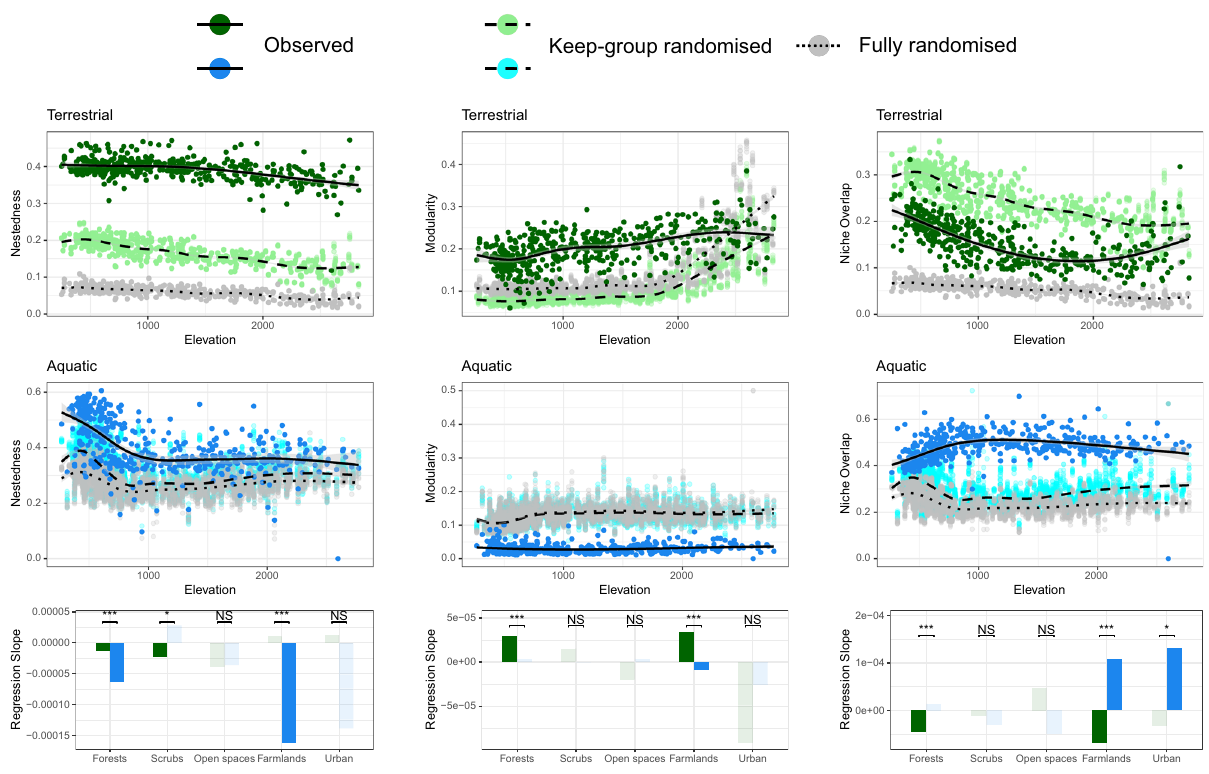
Fig. 5 | Nestedness (left panel), modularity (middle panel), and consumers ’ niche overlap (right panel) of terrestrial (green) and aquatic (blue) food webs alongelevation. Inthescatterplots,besidestheobservedvaluesfromtheinferred foodwebs(green/blue),thevaluesfromthekeep-group(lightgreen/blue)andfully (grey)randomisedcounterpartsarepresentedalongsideforcomparison.Theblack lines (solid, dashed, and dotted) are the fi tted regression of generalised additive models with corresponding shades the 95% CI. The bottom barplots present the